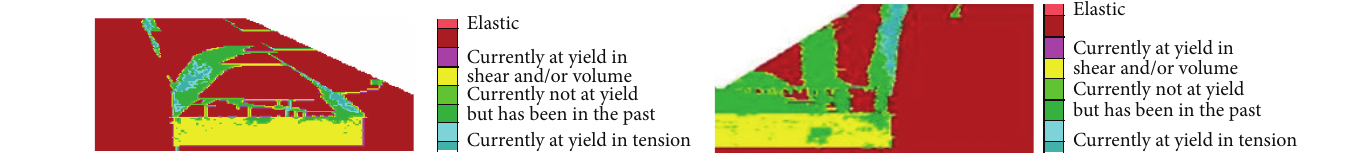
Figure 9: The failure status when mining under gully.